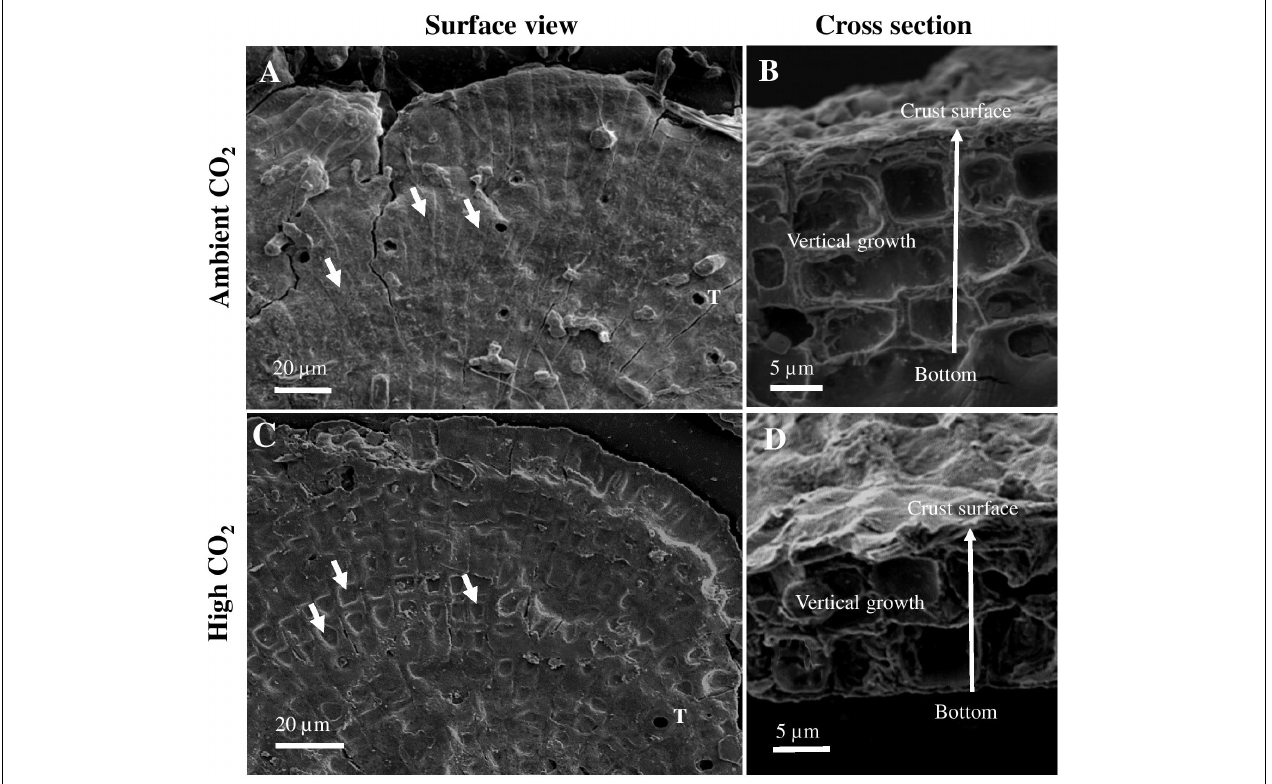
FIGURE 2 | Scanning electron microscopy images of surface view (A,C) and cross section (B,D) of 10-day-old Porolithon cf. onkodes recruits developed under ambient CO 2 (CO 2 between 400.8 and 448.1 µ atm, pH 8.0–8.03) and high CO 2 (CO 2 between 998.9 and 1070.6 µ atm, pH 7.67–7.70) conditions. Arrows in panels (B,D) indicate vertical growth direction. Short white arrows in panel (A) indicate non-collapsed epithallial/perithallial cells and in panel (C) collapsed epithallial/perithallial cells. White T in panels (A,C) indicate first appearance of mega cells (trichocytes).